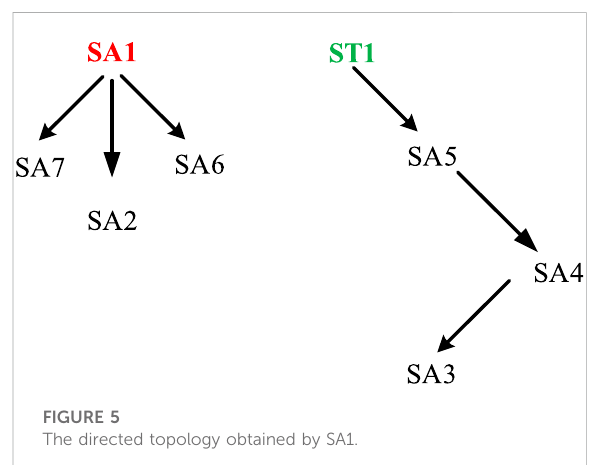
FIGURE 5 The directed topology obtained by SA1.